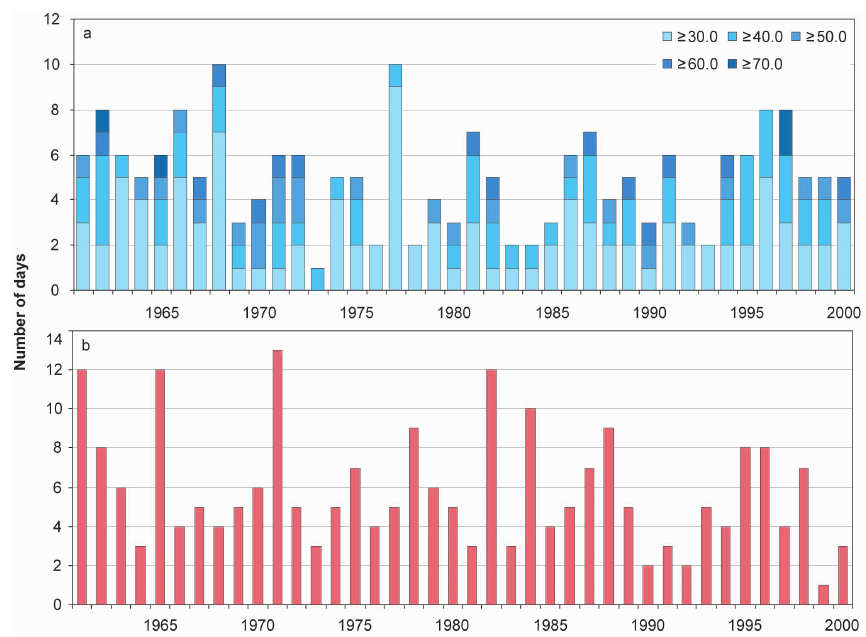
Fig. 7. Frequency of May–August days with daily precipitation totals above limit value (a) and days with hailstorm (b) recorded for at least one CHMI weather station in the area studied during the 1961–2000 period.